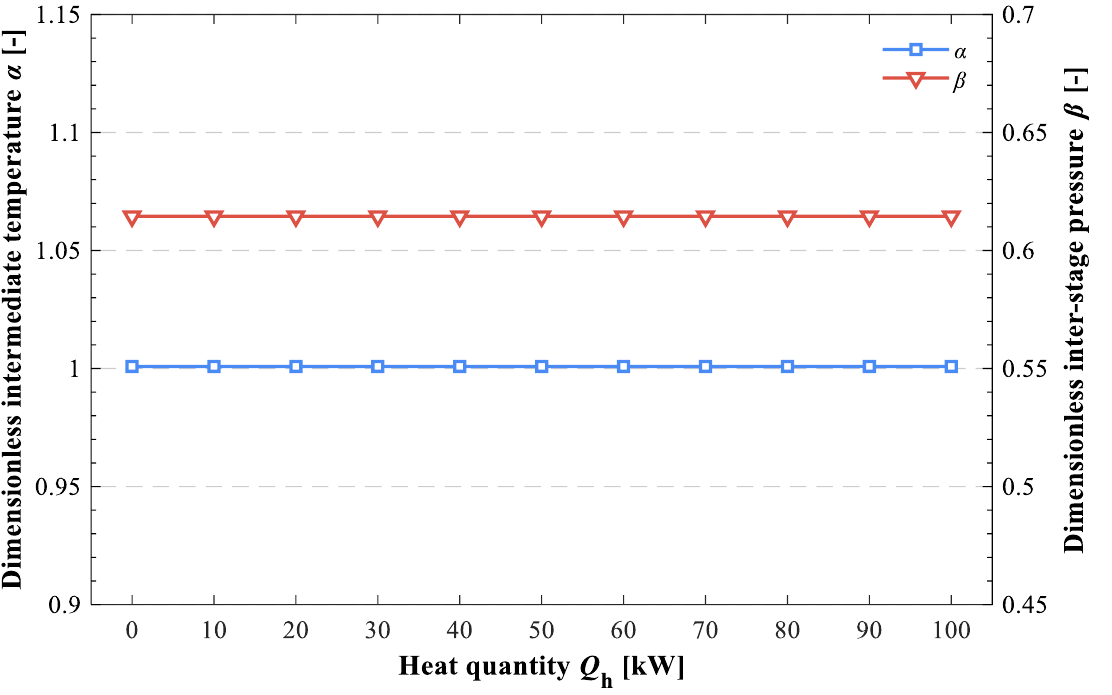
Figure 16. Effect of heat quantity on dimensionless optimum intermediate temperature and inter- stage pressure.